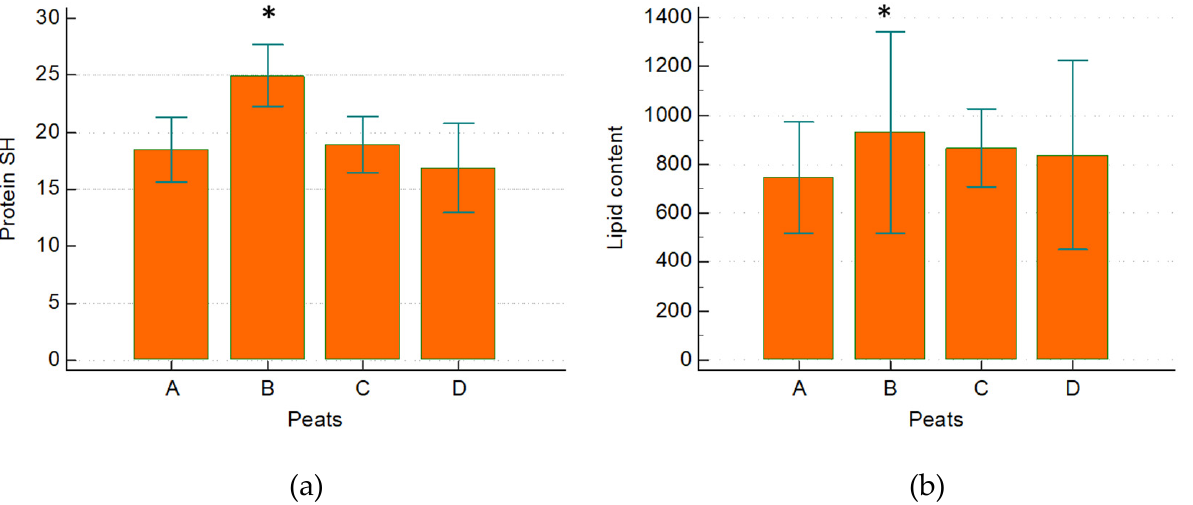
Figure 3. Number of proteins SH ( µ M) ( a ) and lipid content (A.U.) ( b ) found in the M-peat samples: basic peat (A), after 6 months (B), after 16 months (C), and after 36 months (D). Protein SH: * p < 0.001 versus A, C, and D. Lipid content: * p = 0.026 versus A.